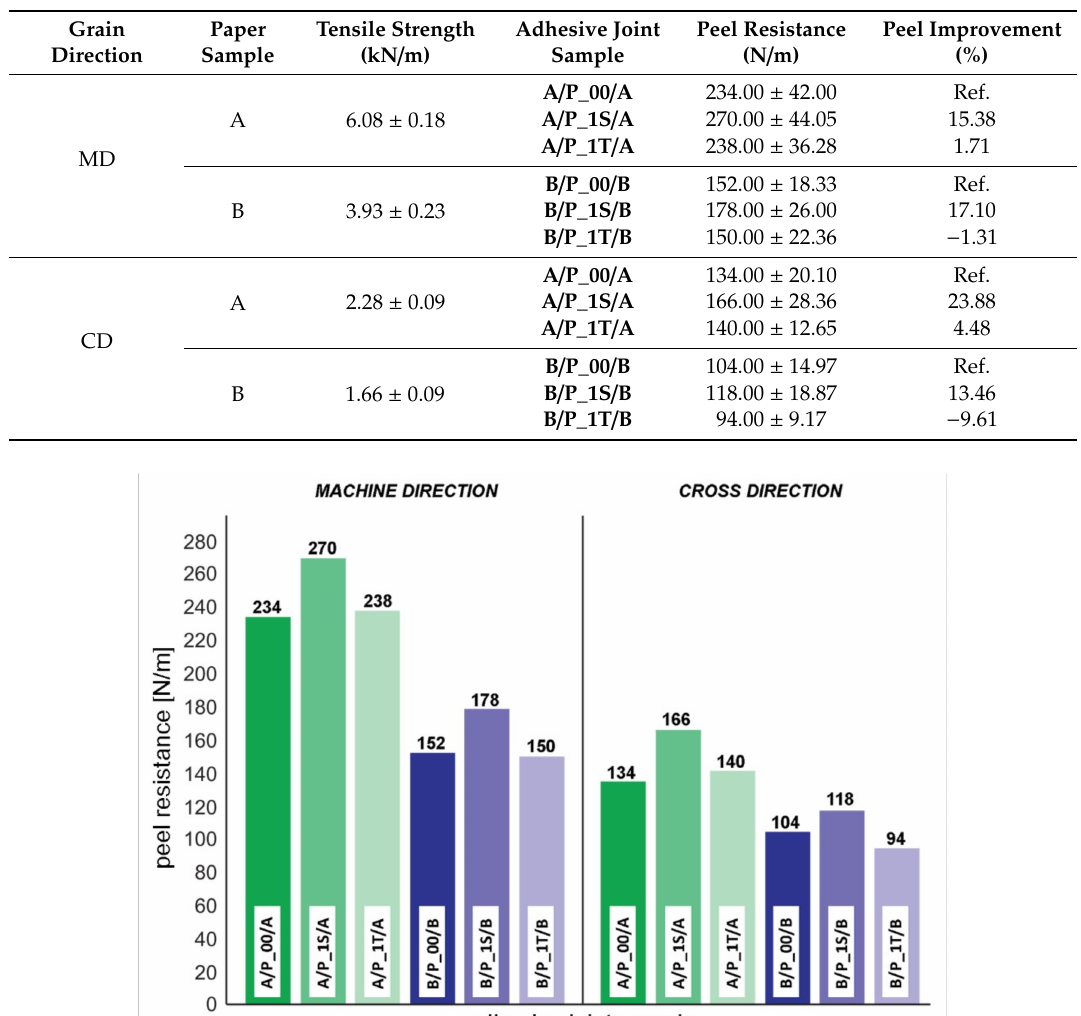
Table 7. Adhesive joints peel resistance with paper tensile strength, for MD and CD paper grain direction, and improvement of peel resistance for joints with nano-enhanced adhesives.